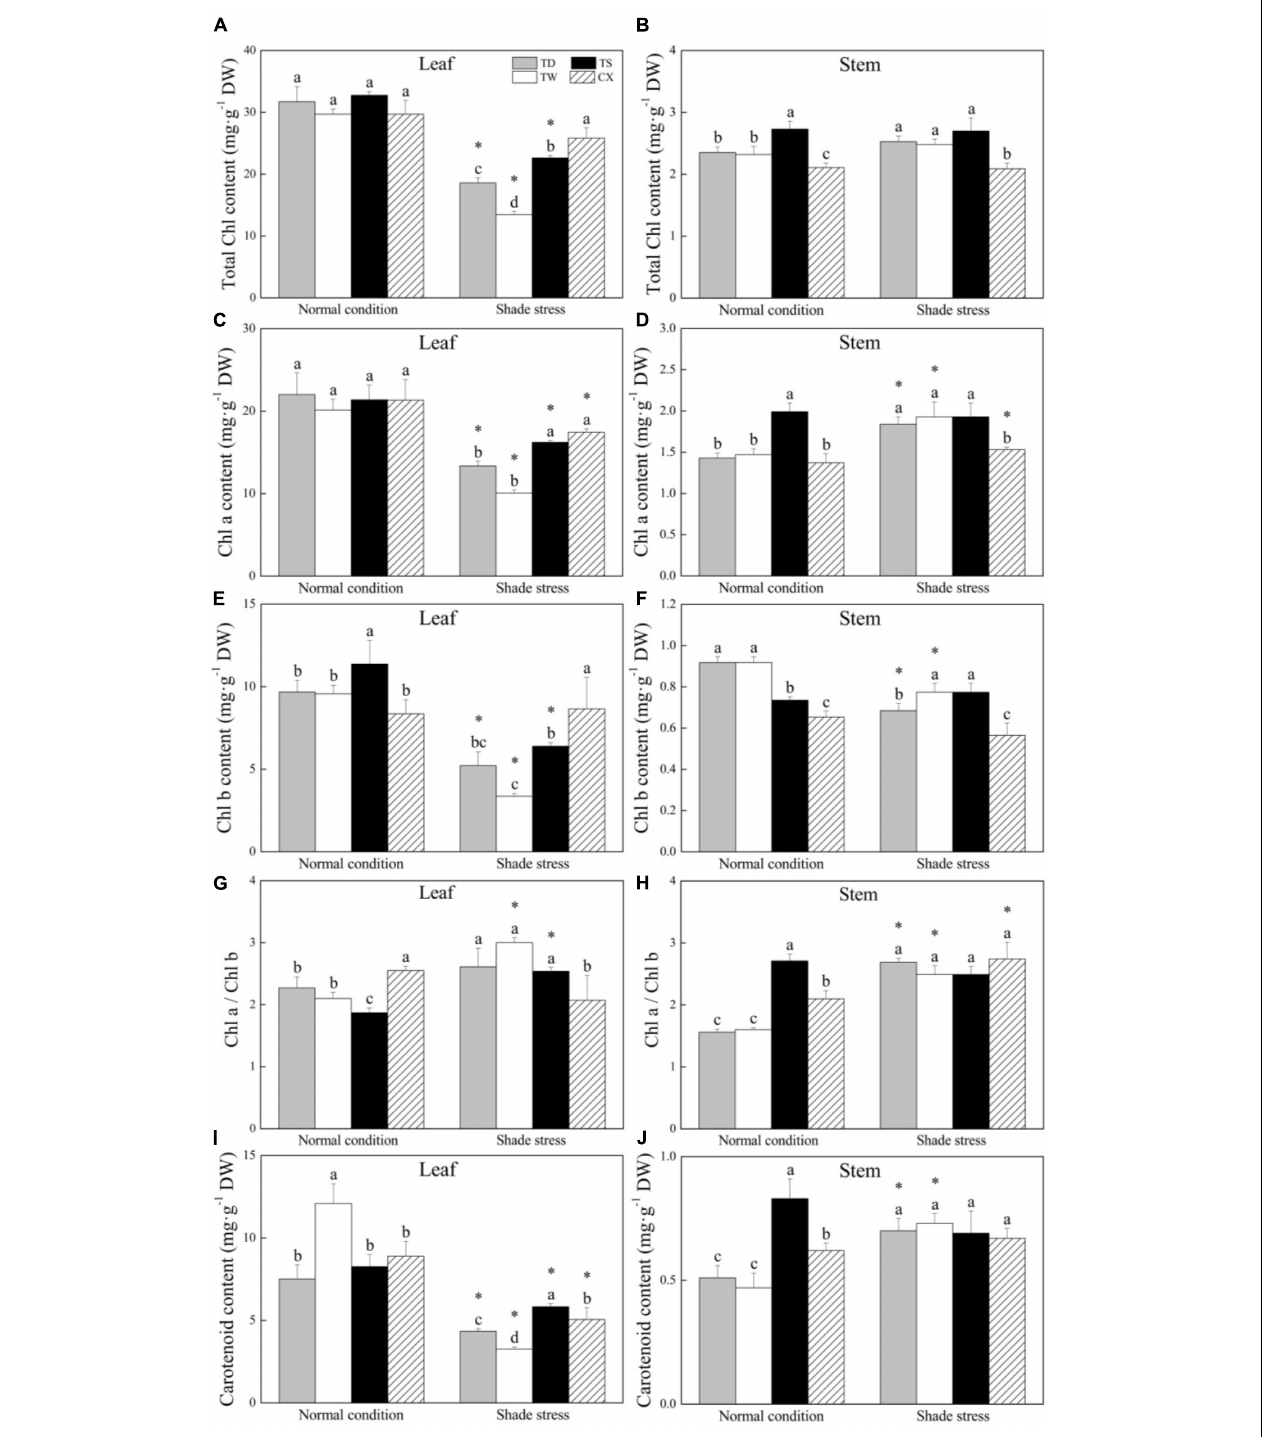
FIGURE 3 | Effects of shade stress on (A) total chlorophyll (Chl) a content in leaf, (B) total Chl a content in stem, (C) Chl a content in leaf, (D) Chl a content in stem, (E) Chl b content in leaf, (F) Chl b in stem, and (G) the ratio of Chl a to Chl b in leaf, (H) the ratio of Chl a to Chl b in stem, (I) carotenoid content in leaf, and (J) carotenoid content in stem of four bermudagrass cultivars. Vertical bars indicate the ± SE of mean ( n = 4). Different letters above columns indicate significant differences ( p ≤ 0.05) among four cultivars under normal conditions or shade stress. The asterisk ( ∗ ) above letter indicates a significant difference ( p ≤ 0.05) in one particular cultivar between normal conditions and shade